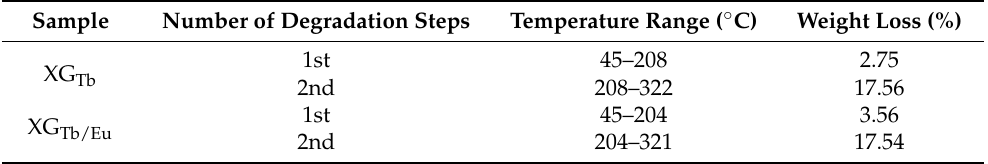
Table 1. The parameters from TG analysis for studied sol–gel materials.